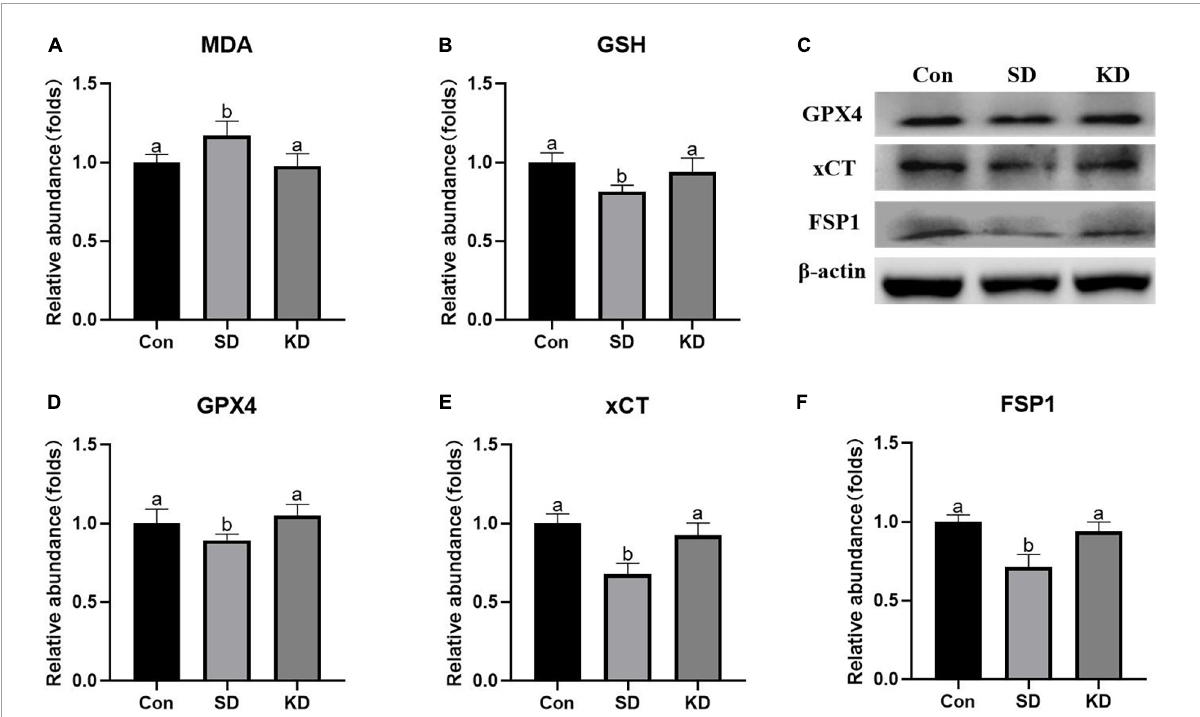
FIGURE6 Effects of ketogenic diet (KD) on lipid peroxidation mediated oxidative stress in hippocampus induced by chronic sleep deprivation (SD). (A) Levels of malondialdehyde (MDA) and (B) glutathione (GSH). (C) Western-blots and (D–F) densitometry of GPX4, xCT, and FSP1. Protein levels are normalized to β -actin which served as loading control and reproduced with Sham group. Values are indicated as the mean ± SEM ( n = 7). Different letter indicates significantly different between each group ( p <